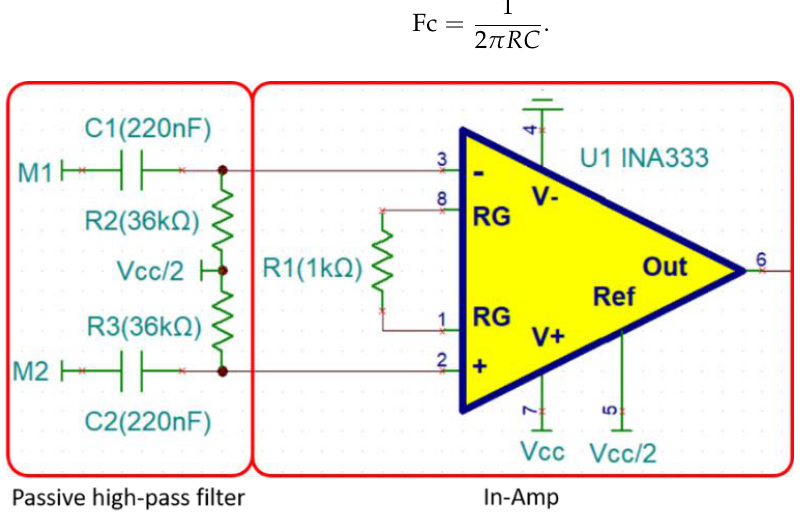
Figure 8. In-Amp with passive high-pass filter architecture.